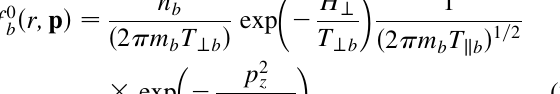
FIG. 2. Plot of average longitudinal momentum distribution (cid:1) p ; t (cid:2) at time t (cid:7) 0 (thin line) and t (cid:7) 150 ! (cid:6) 1 F b z for normalized beam intensity s